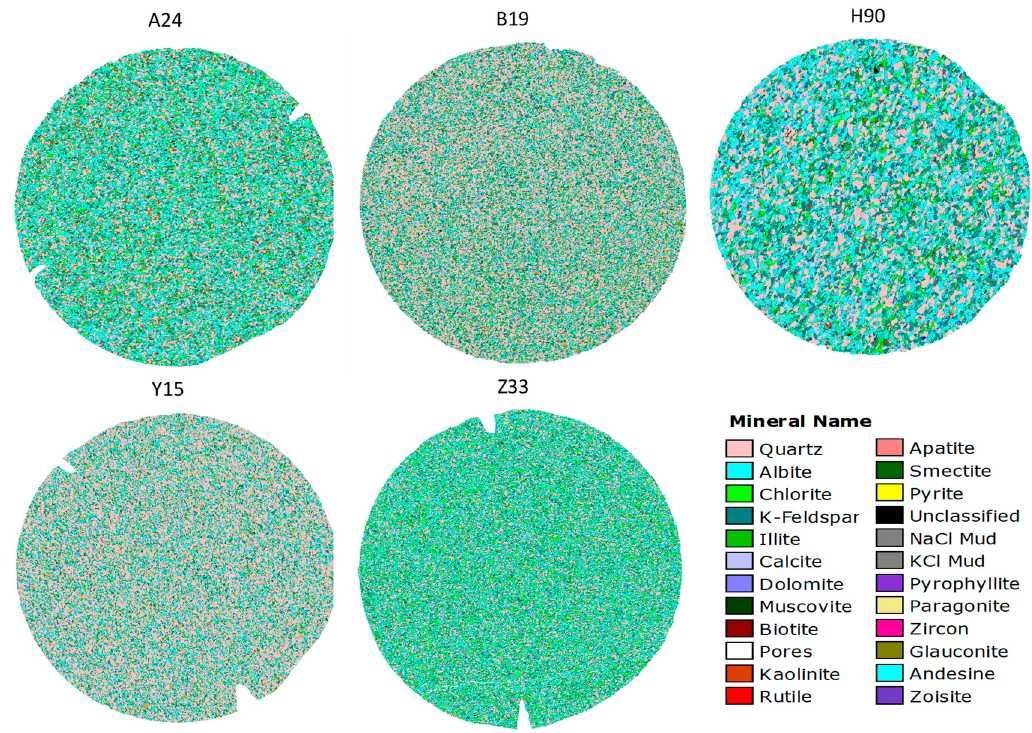
Figure 1. The types and distributions of minerals in the core plugs from five different zones. 129